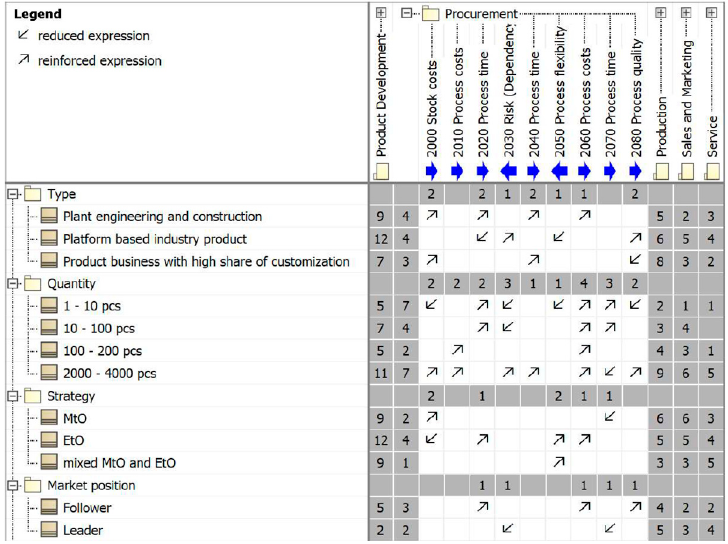
Figure 5. Dependency matrix representation of boundary conditions for economic effects.